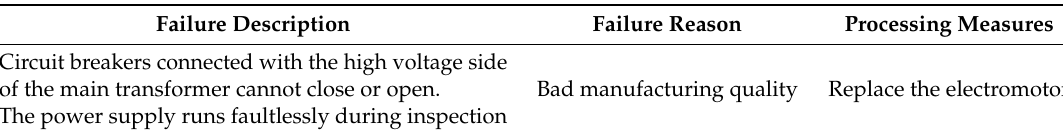
Table 2. A typical manual log entry